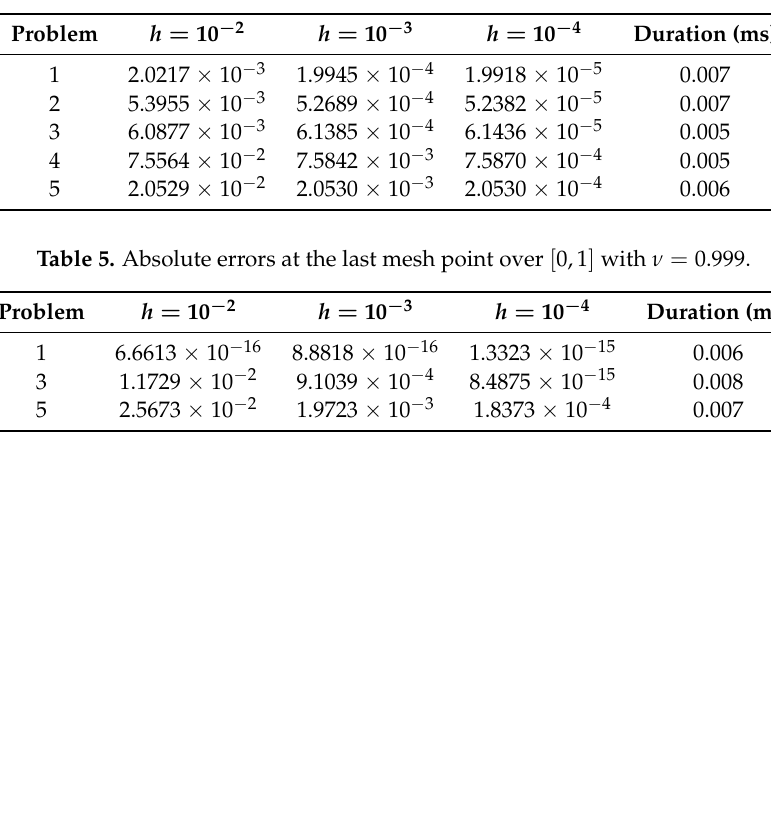
Table 4. Absolute errors at the last mesh point over [ 0,1 ] with ν =